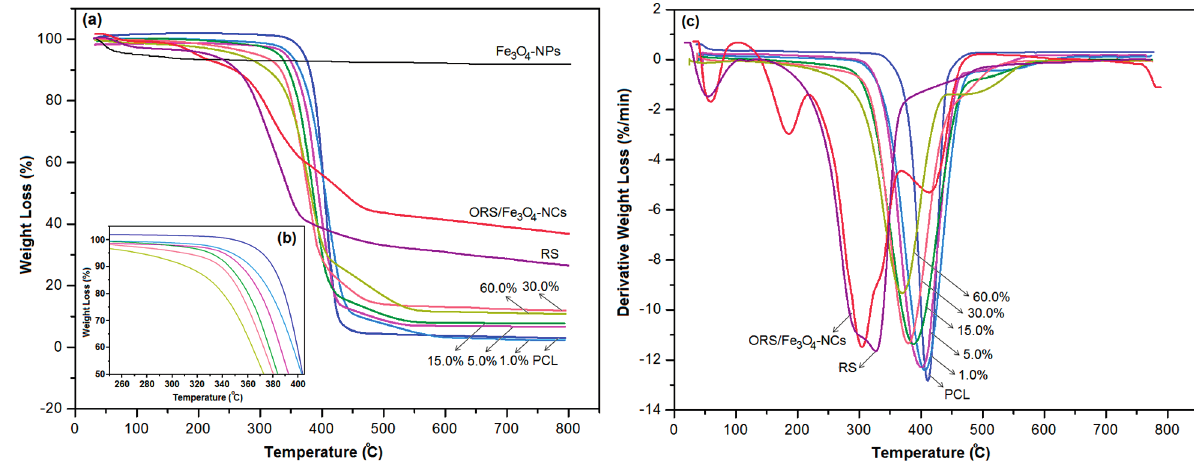
Figure 8. TGA ( a , b ) and DTG ( c ) thermograms of PCL, Fe 3 O 4 -NPs, ORS/Fe 3 O 4 -NCs and ORS/Fe 3 O 4 /PCL-NCs, with 1.0, 5.0, 15.0, 30.0 and 60.0 wt. % ORS/Fe 3 O 4